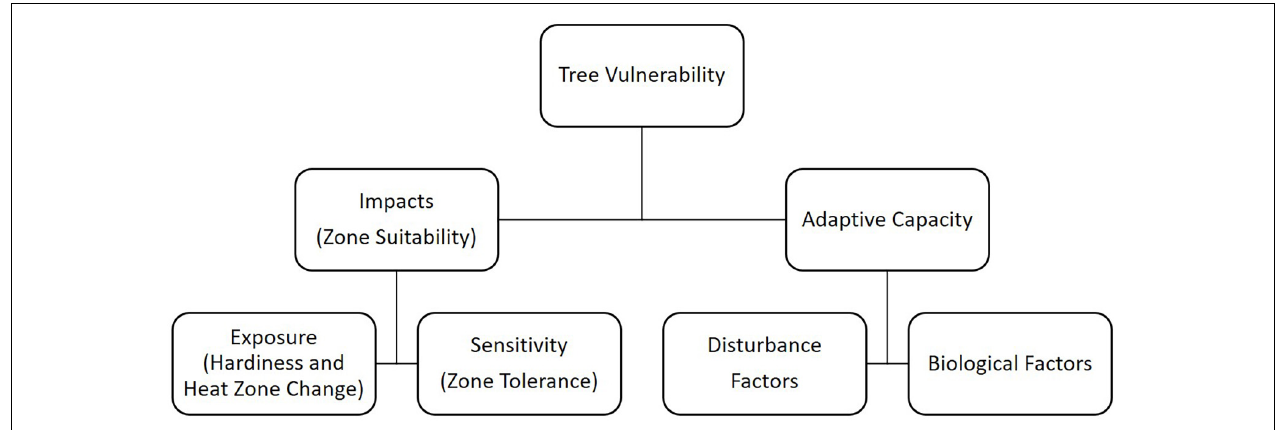
FIGURE 1 | Urban tree species vulnerability